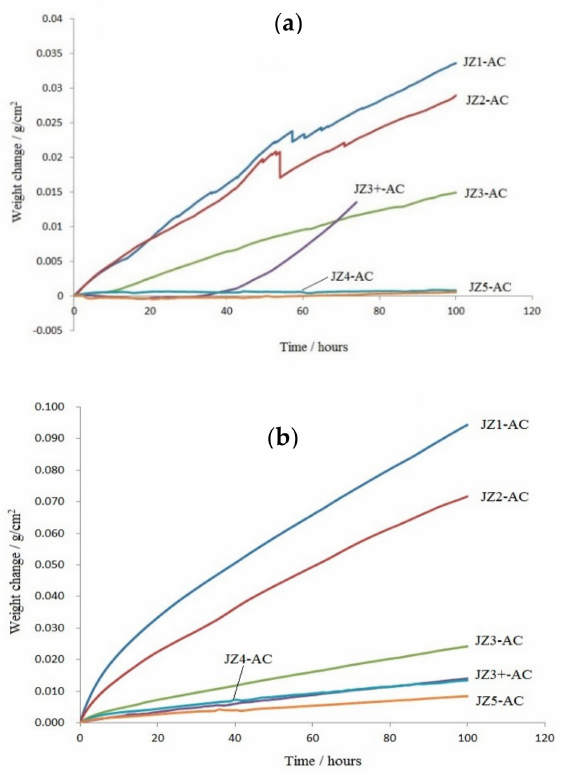
Figure 2. Thermal gravimetric (TG) data for the isothermal oxidation of the alloys JZ4 and JZ5 together with the data for the alloys JZ1, JZ2 [46], JZ3 and JZ3 + [47]. ( a ) 800 ◦ C, ( b ) 1200 ◦ C.